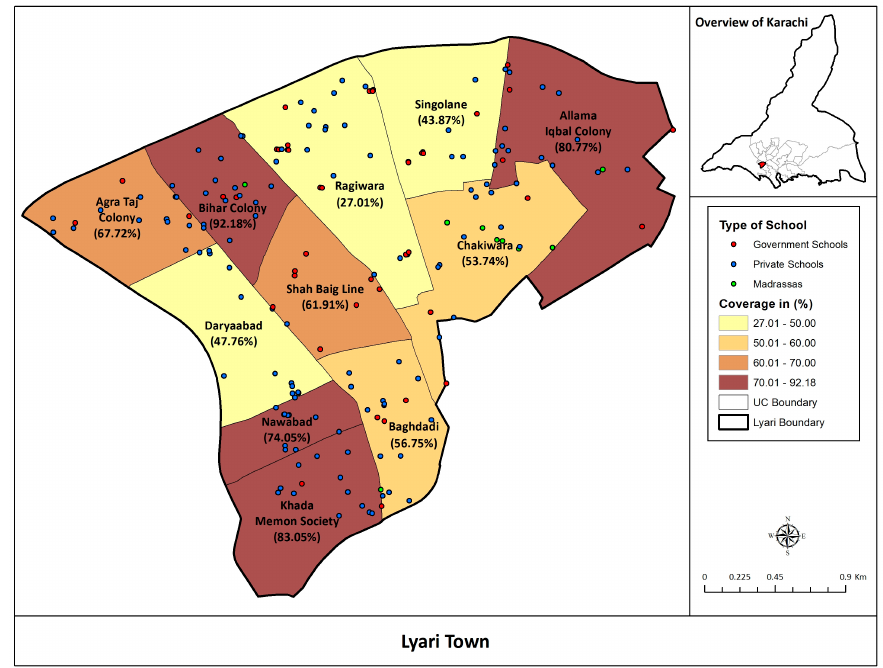
Figure 1. Estimated Coverage of Typbar TCV among children 6 months to 15 years of age in Lyari